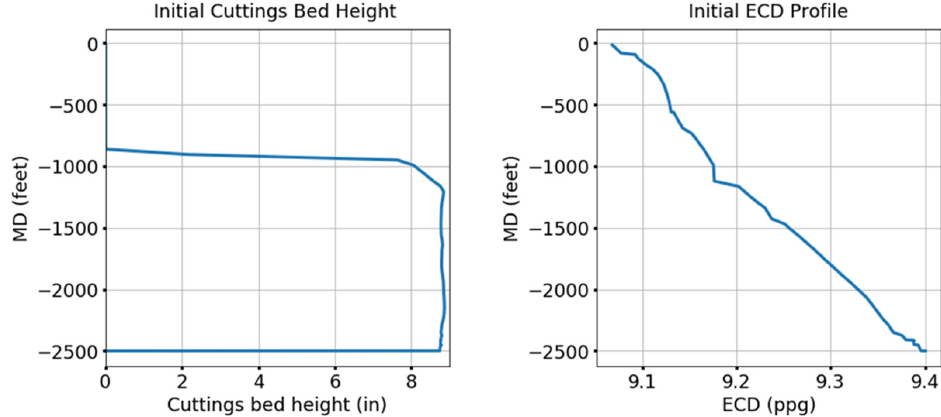
Figure 15. State of the borehole at the end of the drilling operation.